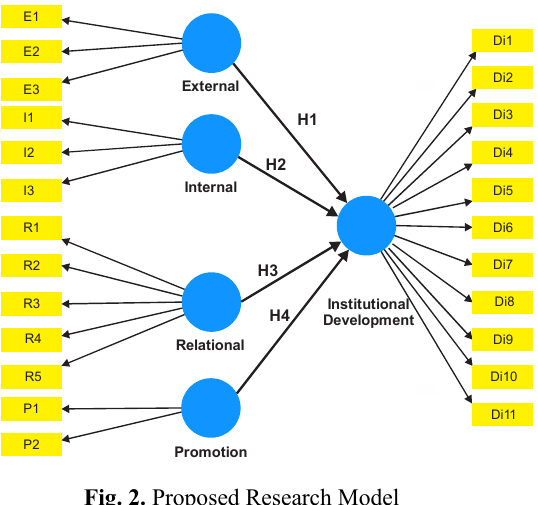
Fig. 2. Proposed Research